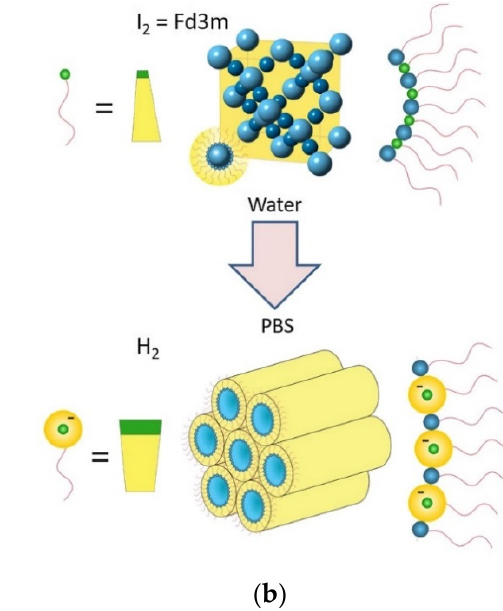
Figure 8. Cubosomes and hexosomes. ( a ) Cryo-TEM image of an aqueous dispersion of cubosomes consisting of the inverse micellar cubic phase Fd3m formed in the monoolein/oleic acid/water system at T = 30 °C at a monoolein/oleic acid weight ratio of 1:1, stabilized by the amphiphilic block copolymer Pluronic F127 (bar: 200 nm), as published by Fong et al. (2020) [82]. ( b ) Schematic representation of the effect of pH and phosphate buffered saline (PBS) on the aggregation state of aqueous mixtures of monoolein, oleic acid (and oleate), and water at T = 30 °C: dispersed inverse micellar cubic phase Fd3m (cubosomes) at pH = 4.3 and low ionic strength ( top ); dispersed inverse hexagonal phase (hexosomes) at pH ~ 7.4 in the presence of PBS ( bottom ). The cubosome → hexosome transformation is explained by considering a change in the geometry of the molecular packing of the amphiphiles. The lipid with blue head group represents monoolein. The lipid with green head group represents either neutral oleic acid at low pH (small head group) or negatively charged oleate at high pH (large head group) [82]. Reproduced with permission from [82], Elsevier,